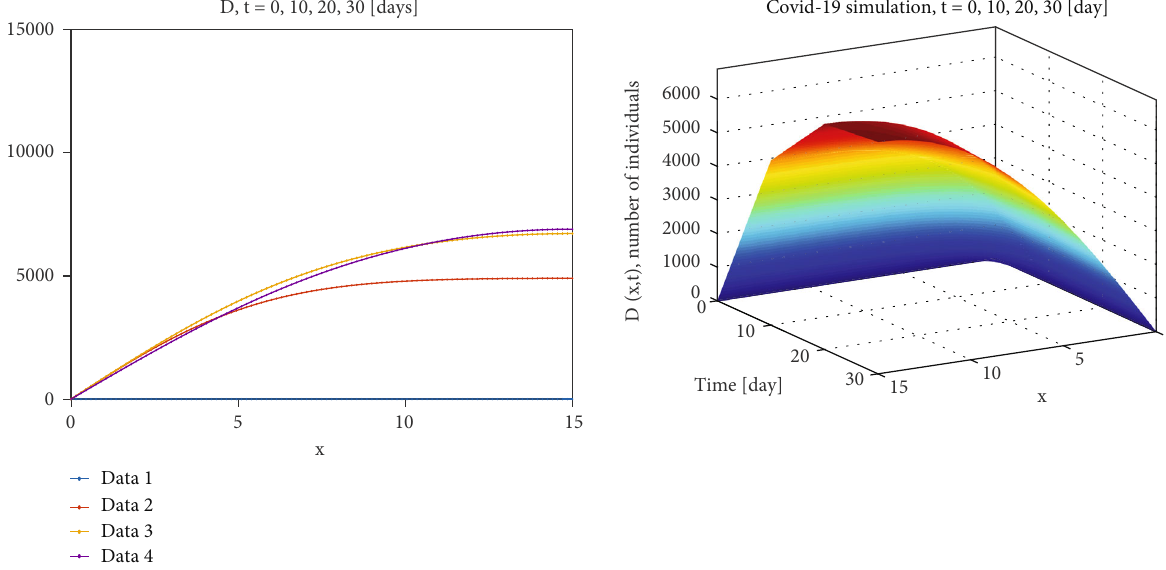
Figure 5: One section and 3-dimensional plot for the proportion of total number of deaths in space and